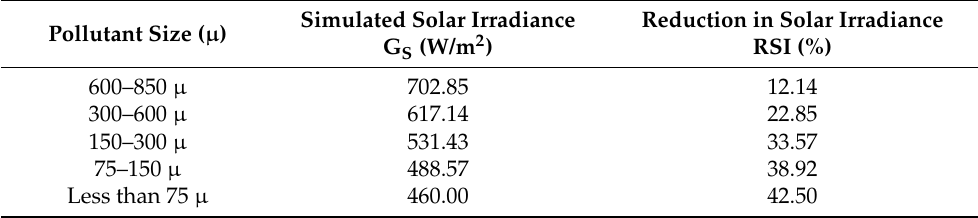
Table 9. Dust pollutant size impact on solar Irradiance under the same deposition density.